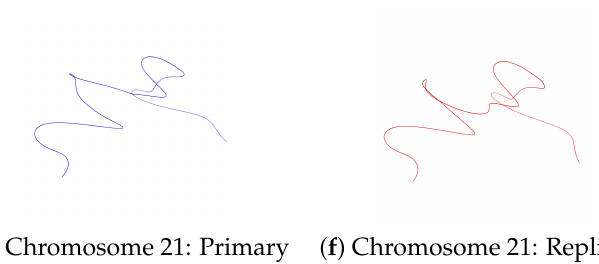
Figure A1. 3D structures produced by CBCR on the primary and replicate maps of GM12878 at 1 mb.